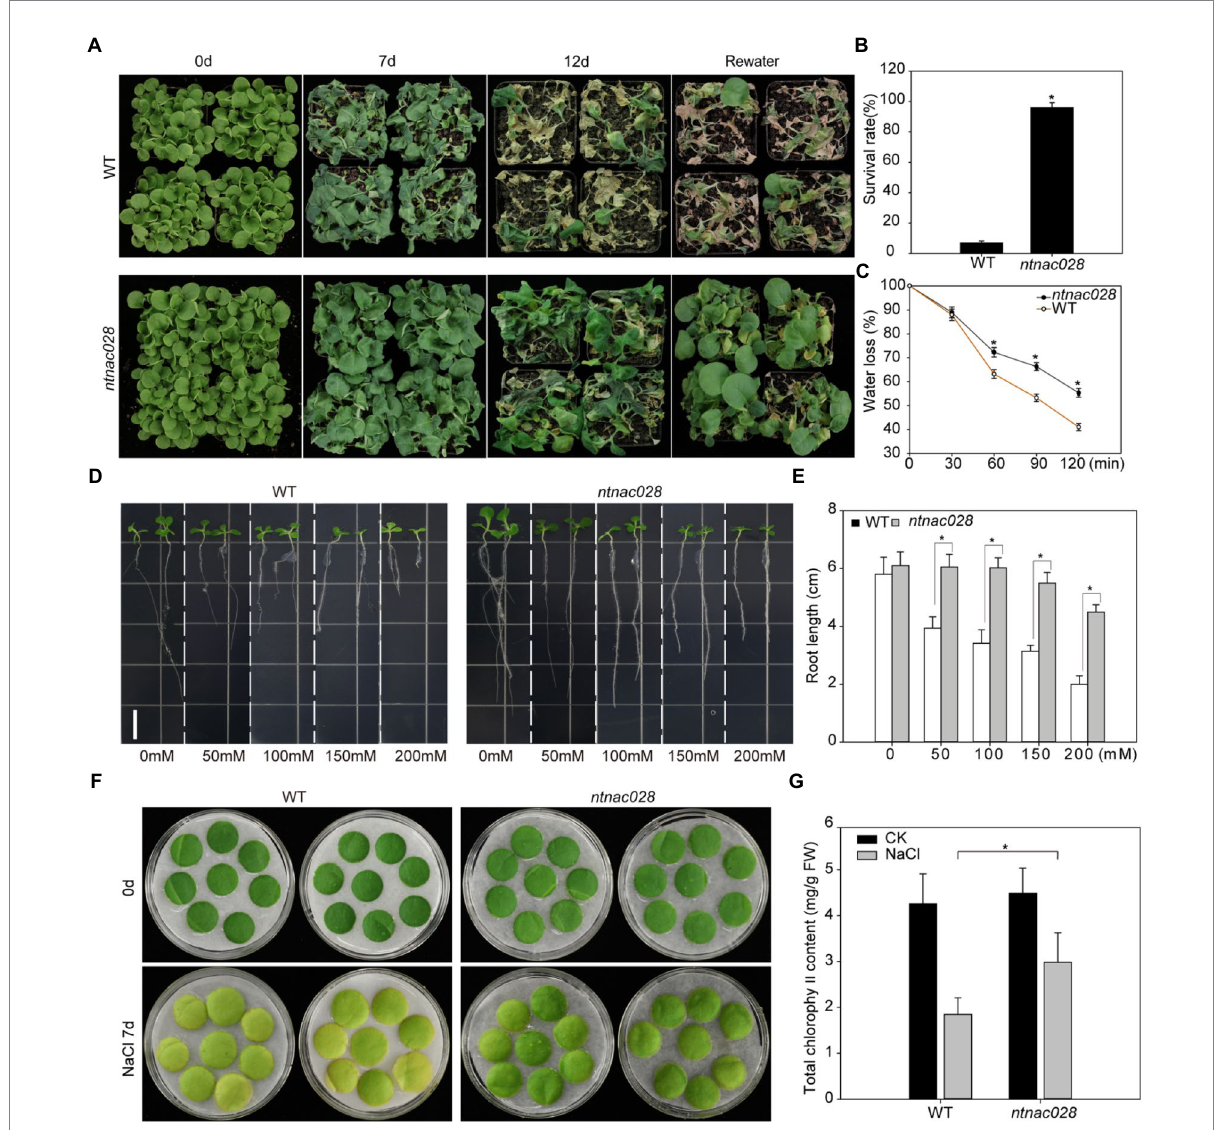
FIGURE 3 CRISPR/Cas9-mediated knockout of NtNAC028 enhances abiotic stress tolerance in tobacco. (A) Phenotypes of tobacco plants treated with drought stress for 12 days and recovered with water for 2 days. (B) Phenotypes of ntnac028 and wild-type tobacco under drought stress. (C) Water loss rates of detached leaves from WT and ntnac028 . Water loss was determined as the percentage of initial fresh weight. Values are means from 10 plants for each of three independent experiments. (D,E) Root length of WT and ntnac028 under control and NaCl treatments. Seedlings were vertically cultivated on MS plates containing 0, 50, 100, 150, or 200 mM NaCl. Images were taken after 5 days. Bars = 1 cm. Data were calculated using 20 seedlings for each genotype. The bars are SDs of three biological replicates. Asterisks indicate statistically significant difference from WT (* p < 0.05). (F,G) The phenotypes and chlorophyll content of detached leaves from WT and ntnac028 under NaCl treatment for 7